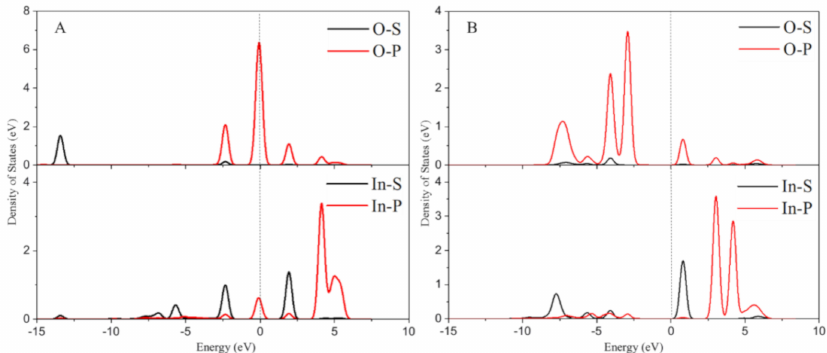
Figure 3. The partial density of states (PDOS) of the In and O atom of ( A ) [InO] + and ( B ) [InOH] 2 +